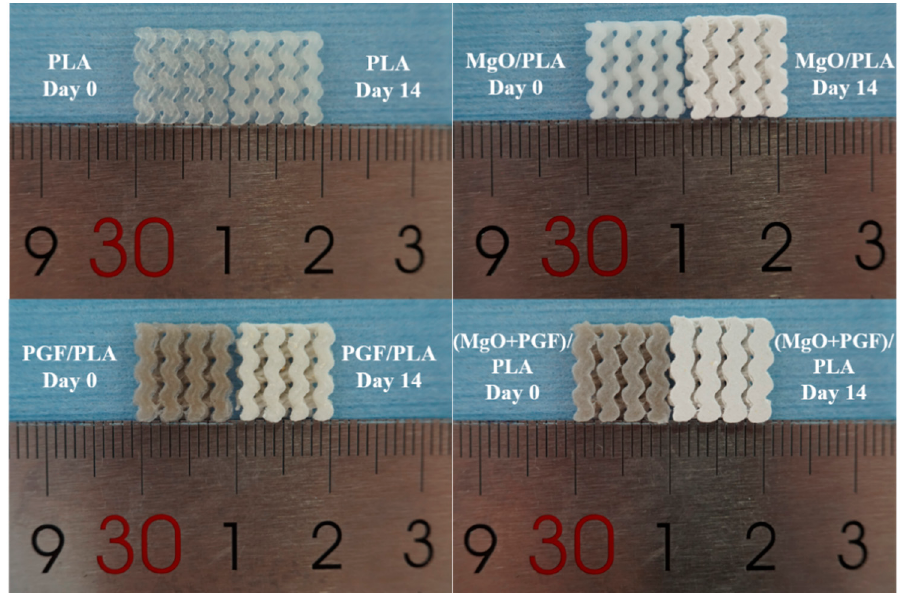
Figure 5. Photograph of scaffolds after 14 days of degradation.